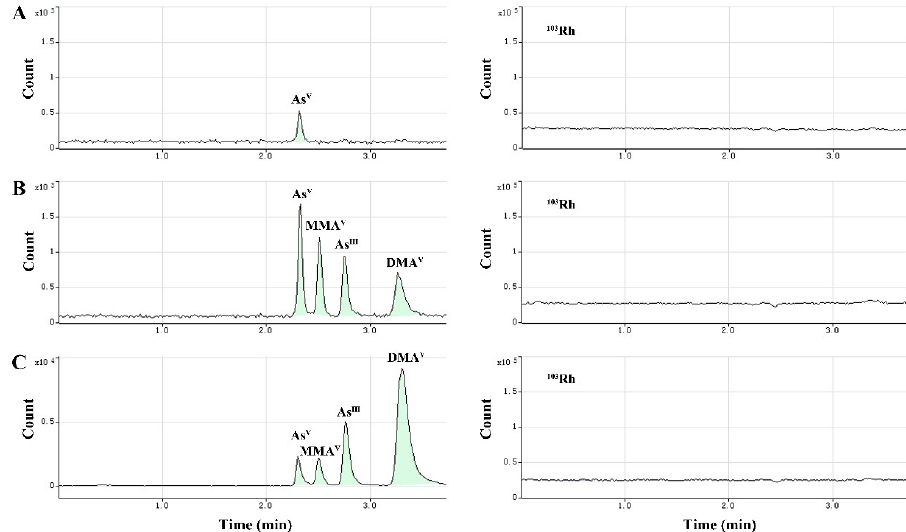
Figure 2. Typical chromatograms showing baseline separation of As species, including As V (retention time (RT) = 2.30 min), MMA V (RT = 2.51 min), As III (RT = 2.77 min) and DMA V (RT = 3.32 min), and Rh internal standard (right-side chromatograms). ( A ) Blank plasma sample, ( B ) blank plasma sample spiked with the analytes at the lower limit of quantitation (LLOQ), ( C ) cynomolgus macaque plasma sample after dosing of arsenic trioxide